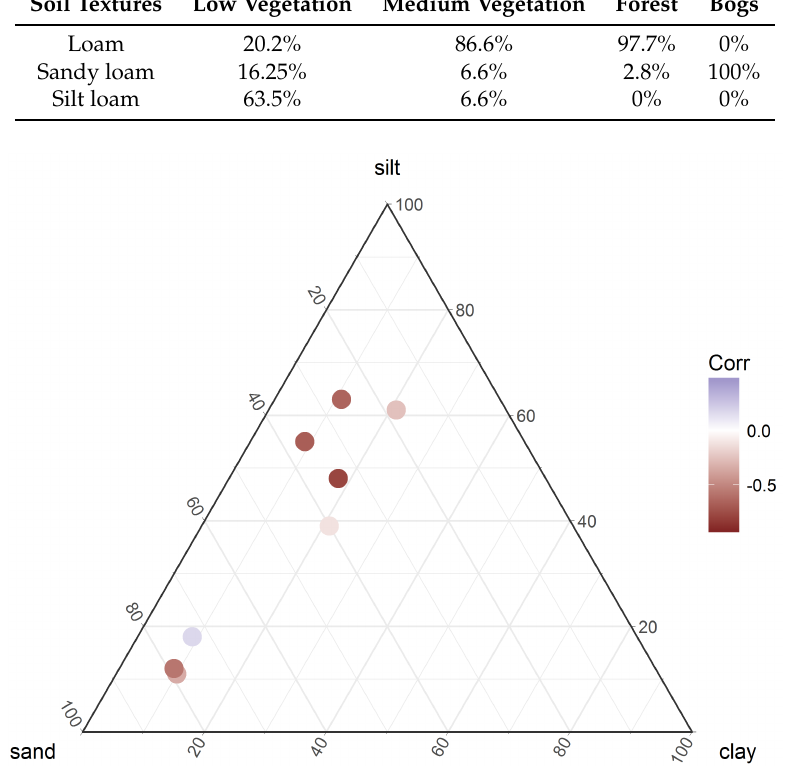
Figure 9. Topsoil sand, silt and clay fraction for all boreholes (with sensors in the upper 20 cm); the color represents the